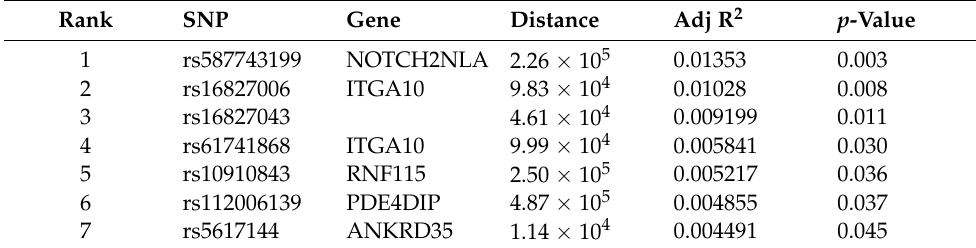
Table 4. Cis-meQTLs nominally associated with cg19693031.